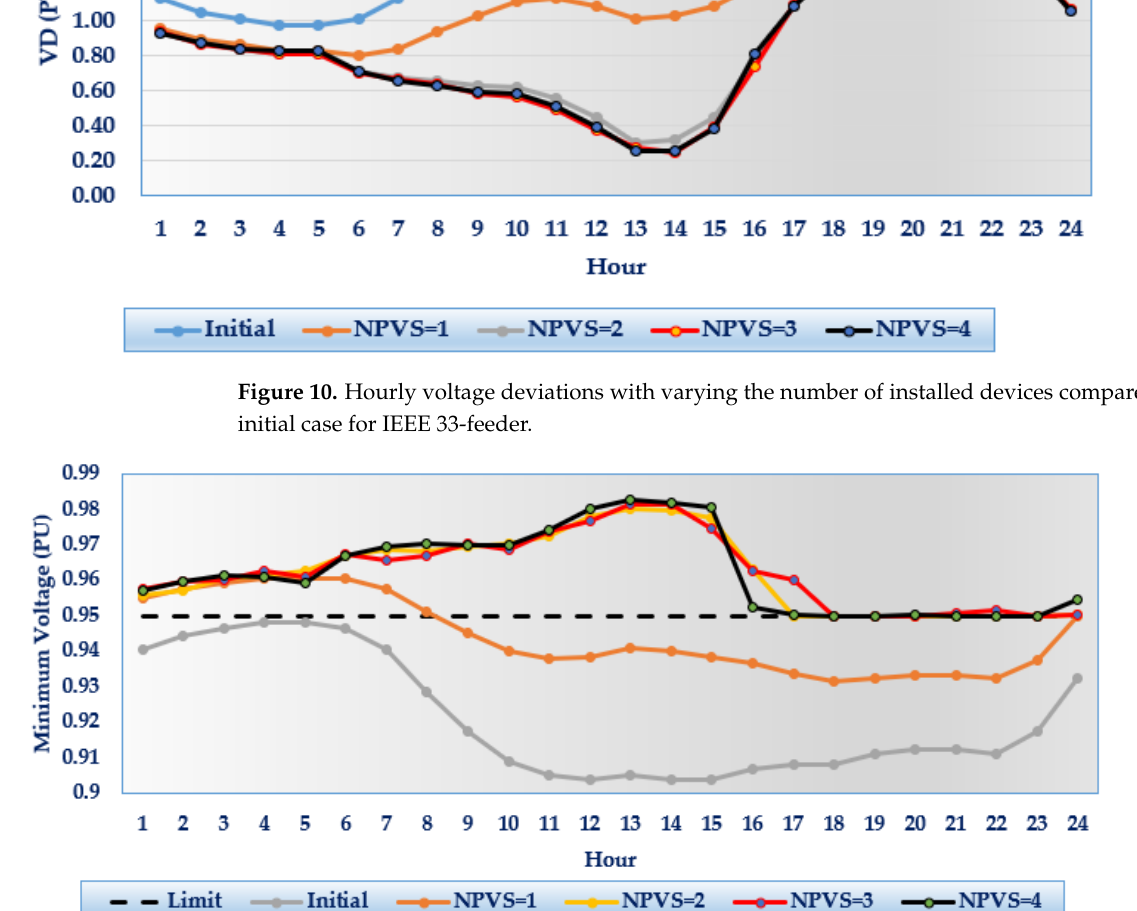
Figure 11. Hourly minimum voltage with varying the number of installed devices compared to the initial case for IEEE 33-feeder.